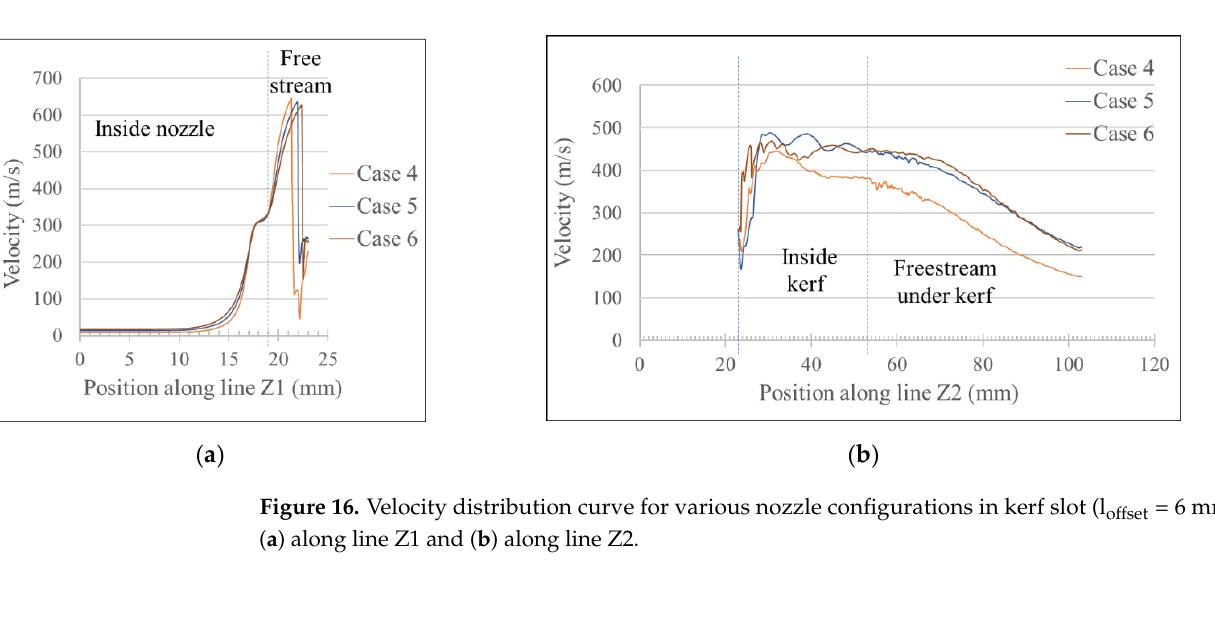
( b ) Figure 17. Velocity distribution curve for various nozzle configurations in kerf slot (l offset = 9 mm): ( a ) along line Z1 and ( b ) along line Z2. 4.1.2. Effect of the Cut Front Slope (Variation in l offset ) on Gas Flow Characteristics The change in slope of the cut front in the kerf slot showed variations in gas flow behavior. As the slope of the inclined cut front decreased (increase in l offset ), a damping effect along the flow direction increased, resulting in a reduction of the flow velocity. The sets of cases 1, 4 and 7; 2, 5 and 8; and 3, 6 and 9 represent cases with the same nozzle and varying slopes of the cut front inside the kerf. The pressure and velocity distribution curve along line Z2 is shown for these sets of cases in Figures 18 and 19, respectively. The pressure distribution curves in Figure 18a show the reduction in the amplitude of the curve as the slope of the cut front is reduced (l offset increased). The nozzle used in these cases was of a 1.5 mm exit diameter. It can be noticed that the pressure distribution curves show a high frequency of oscillation near the top surface in all the cases given in Figure 18a. This phenomenon was observed because of the presence of a higher number of oblique shock waves. The kerf with a lower cut front slope (longer l offset ) experienced a higher degree of damping effect. Therefore, the amplitude of the pressure curve in the kerf with a low cut front slope dampened more rapidly. In the cases shown in Figure 18b,c, the amplitude of the pressure distribution curve increased with the decrease in cut front slope (increase in l offset ). In cases with the highest